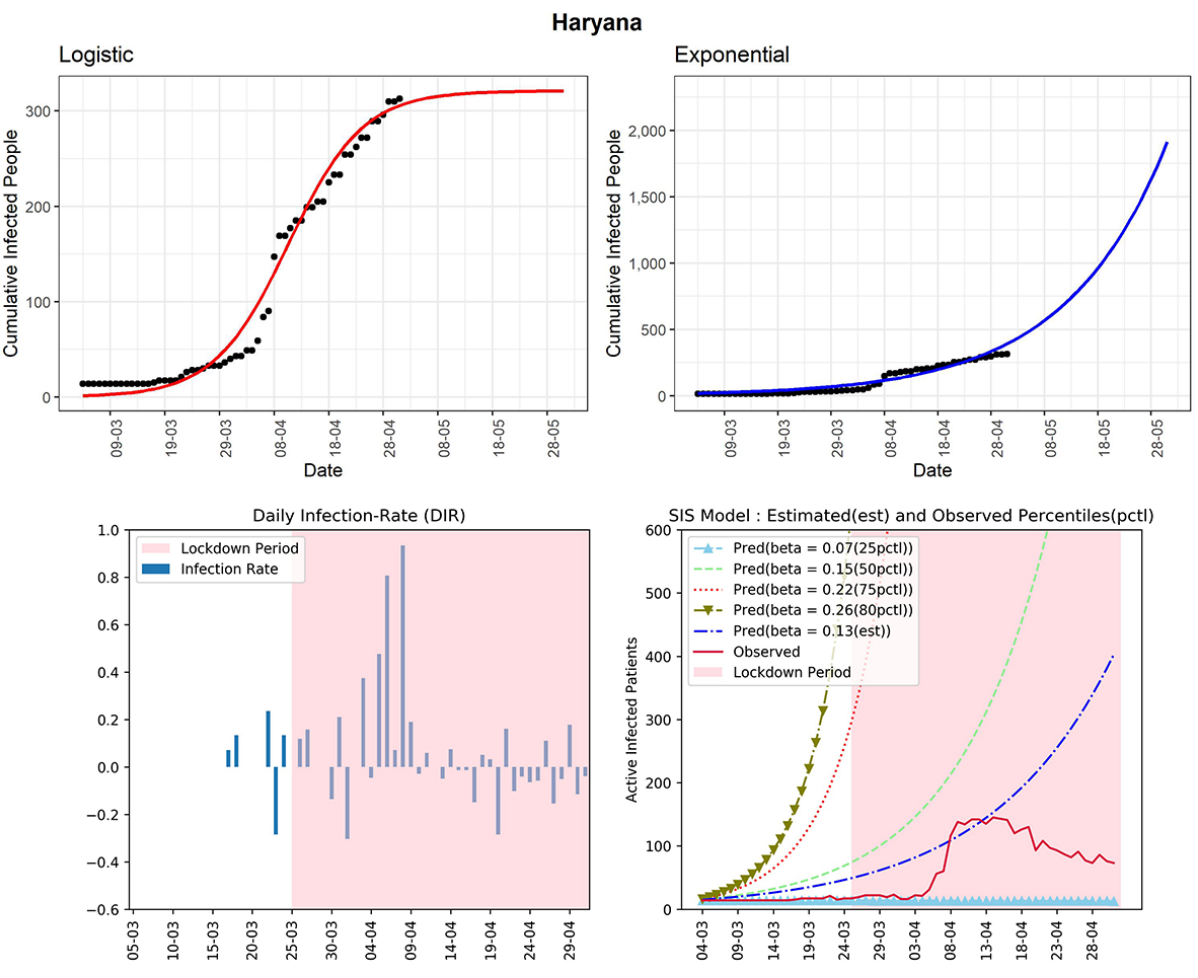
Figure 17. Graphs for the state of Haryana. SIS: